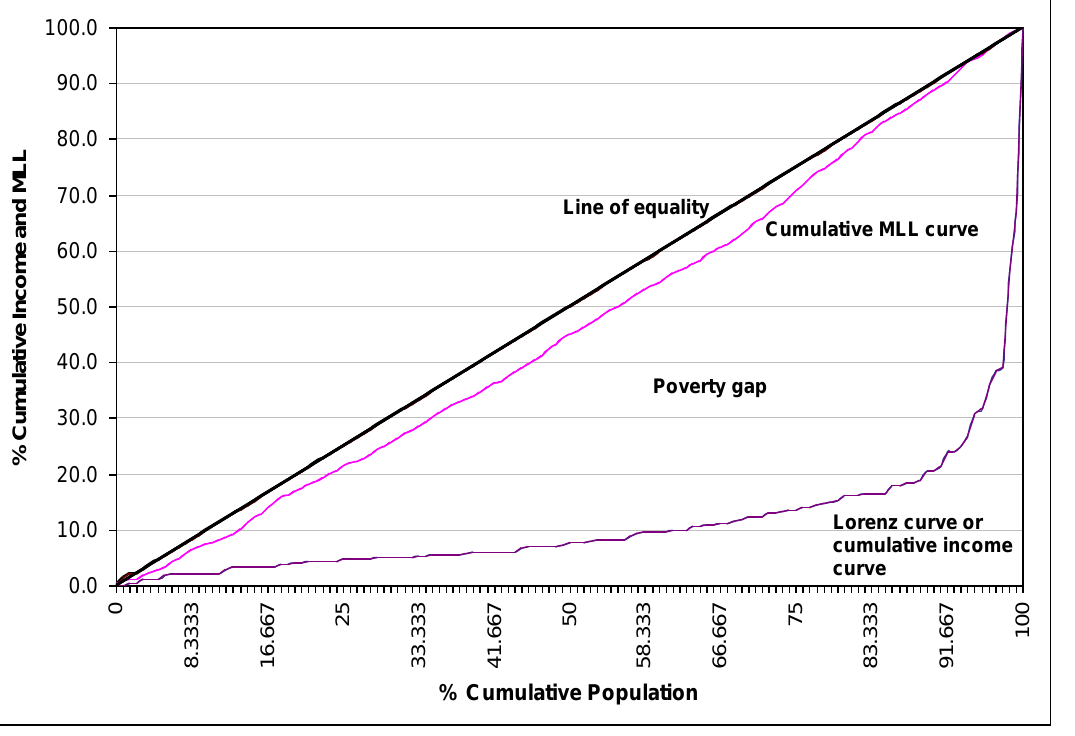
Source: Table 3 and Survey